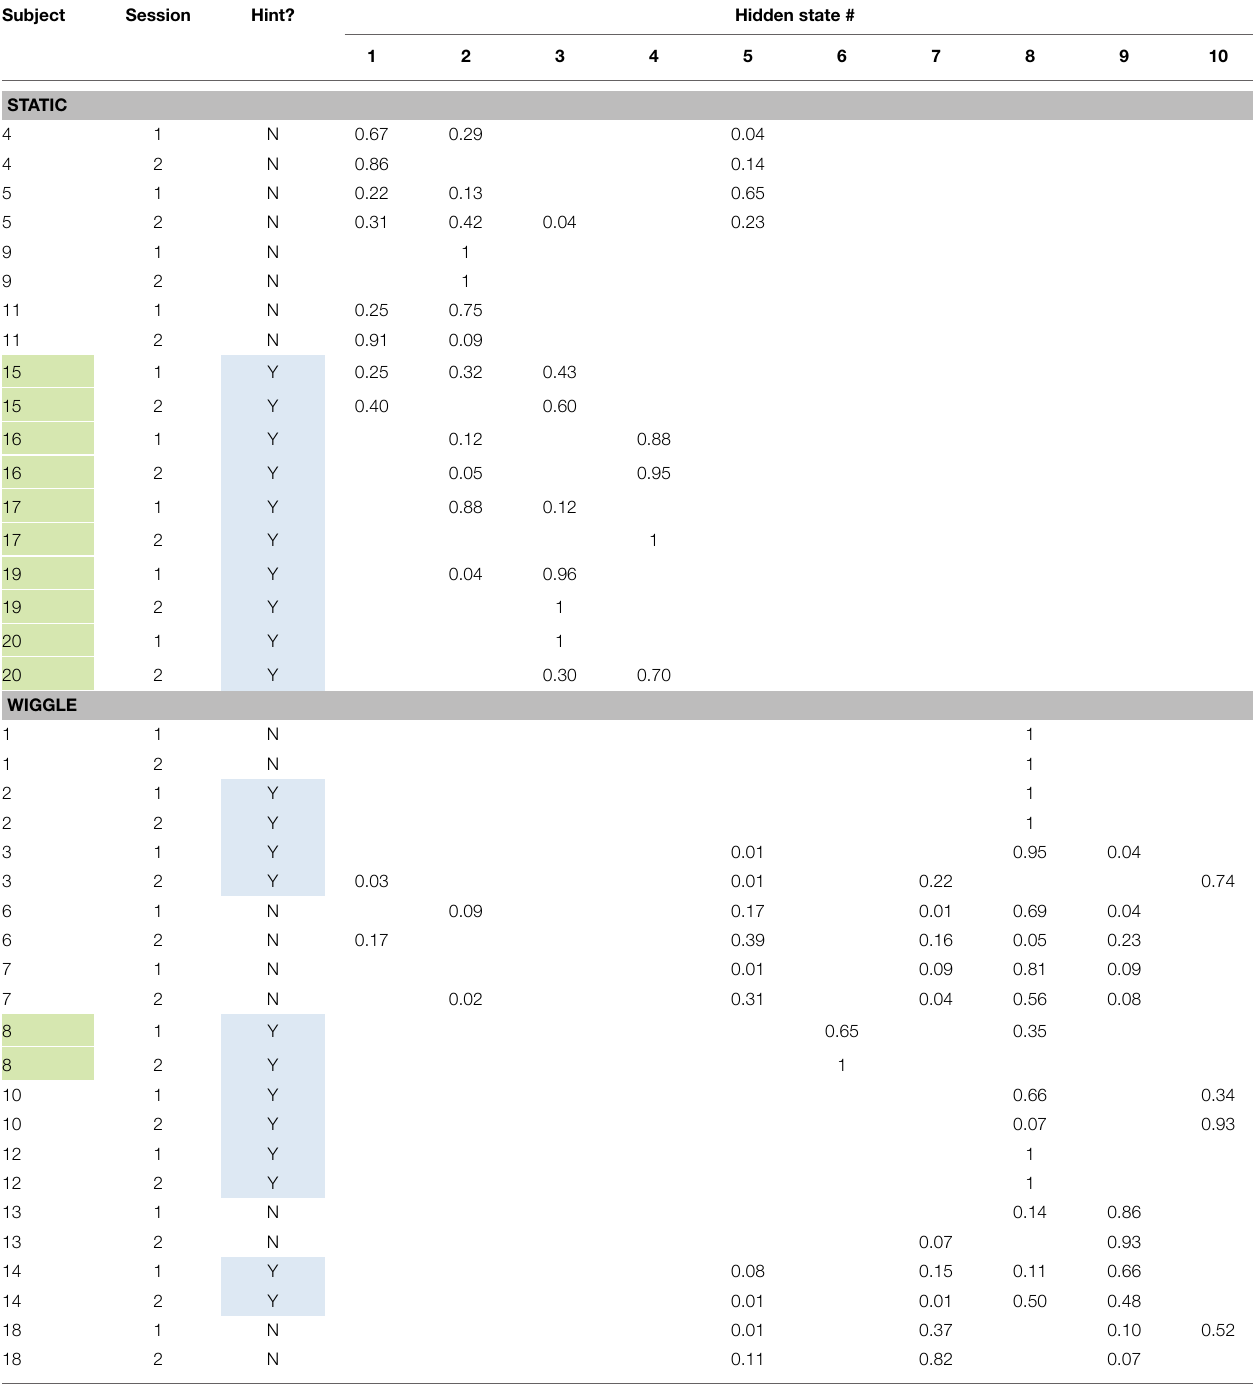
TABLE 4 | Proportion of session time each participant spent in each